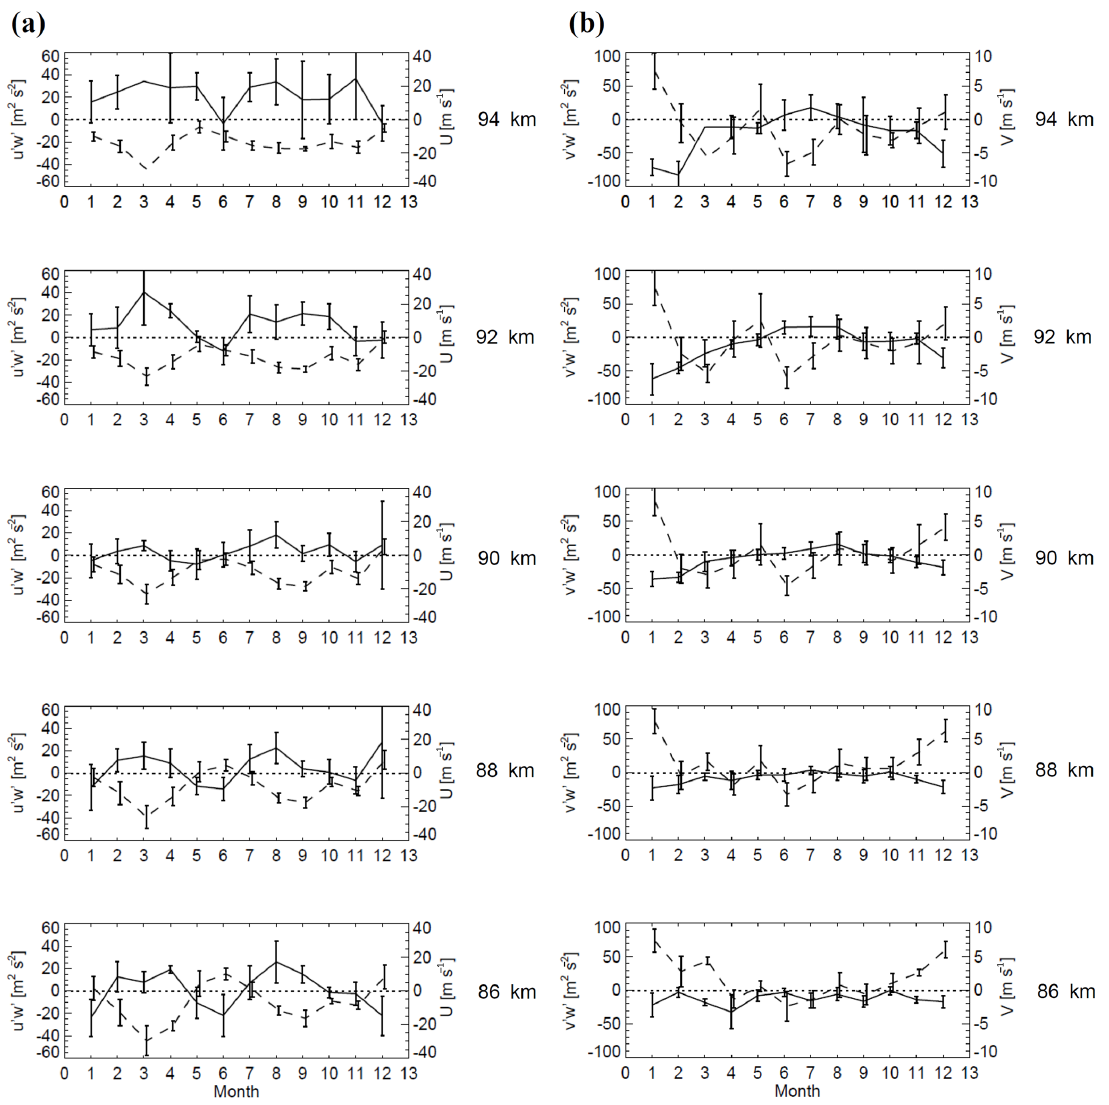
Figure 4. Seasonal variation in (a) u (cid:48) w ’ (solid line) and mean zonal (eastward) wind velocity ( U) (dashed line), and (b) v (cid:48) w (cid:48) (solid line) and mean meridional (northward) wind velocity ( V ) (dashed line) at 86–94km after calculating the monthly mean values in 2002–2013 at Koto Tabang. Error bars show the 95% confidence interval.